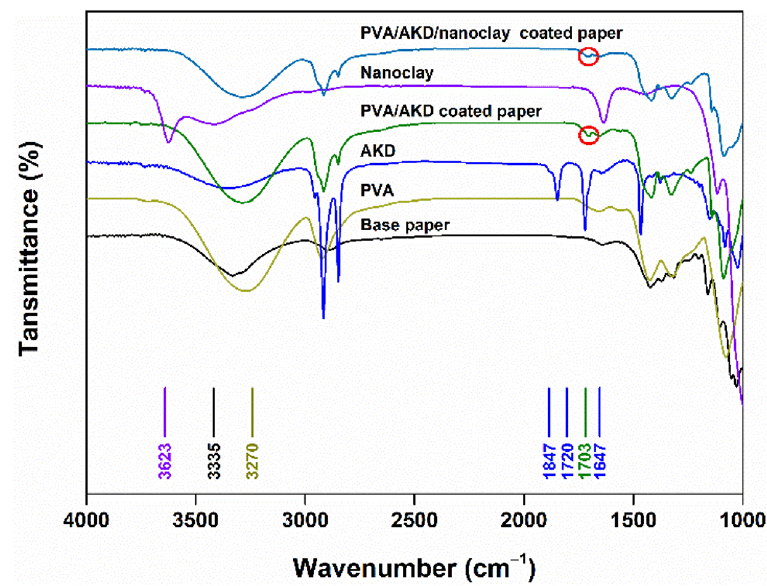
Figure 5. FT-IR spectra of coated papers and the coating components.